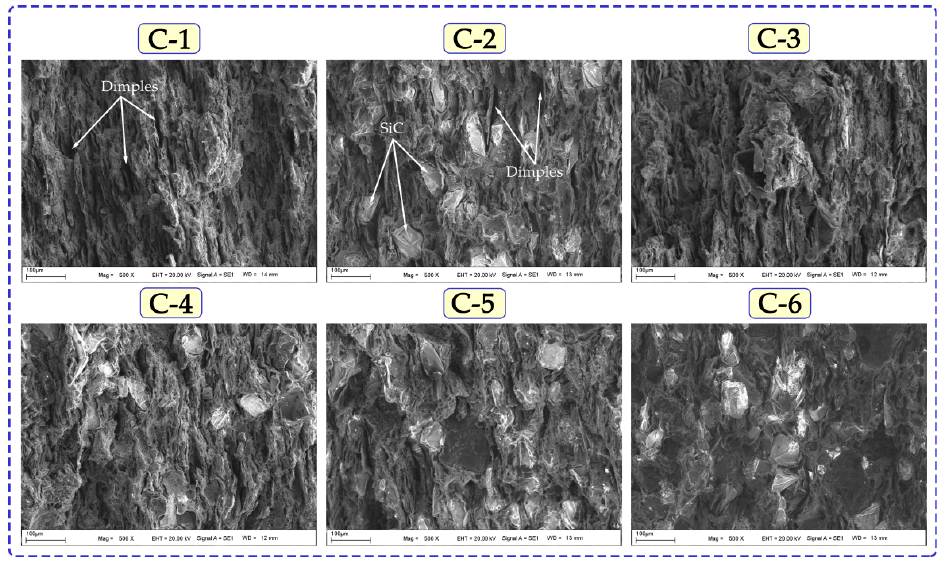
Figure 11. Fractured surface SEM micrographs after the three-point bending test.